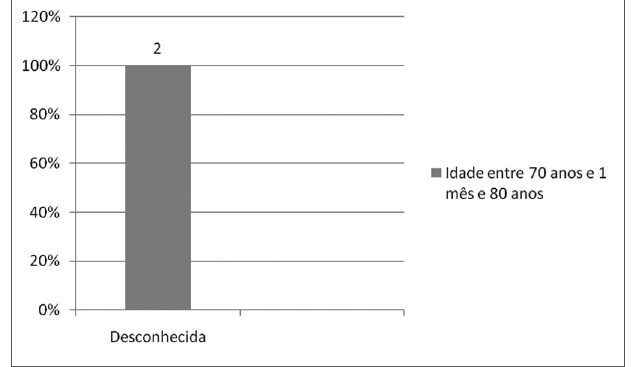
Figura 8. Distribuição etiológica dos pacientes implantados na faixa etária entre 70 anos e 1 mês e 80 anos.